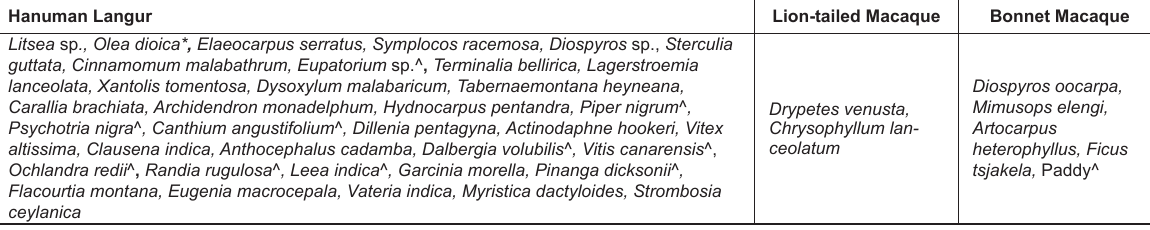
Table 5. Different fodder plants exclusively used by different study groups